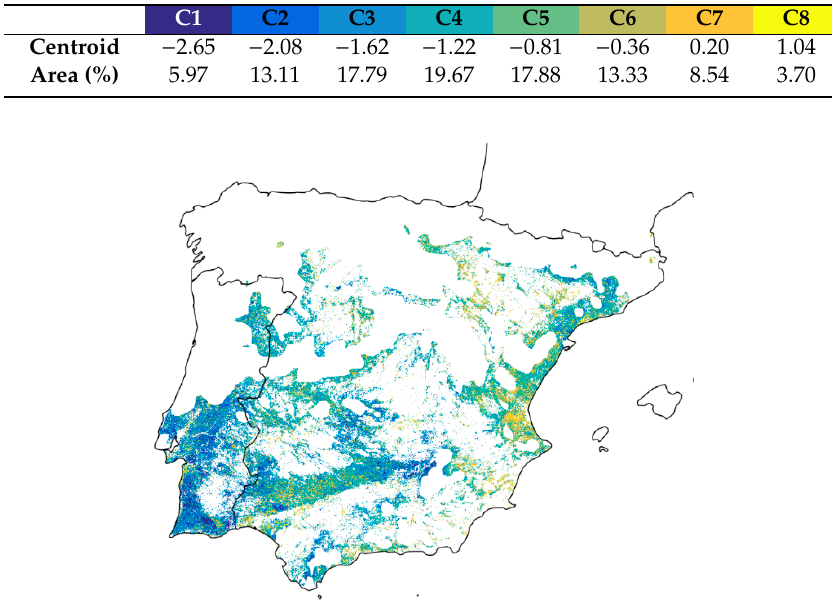
Table 3. Centroids of the eight clusters obtained using NDVI std and respective area (%).